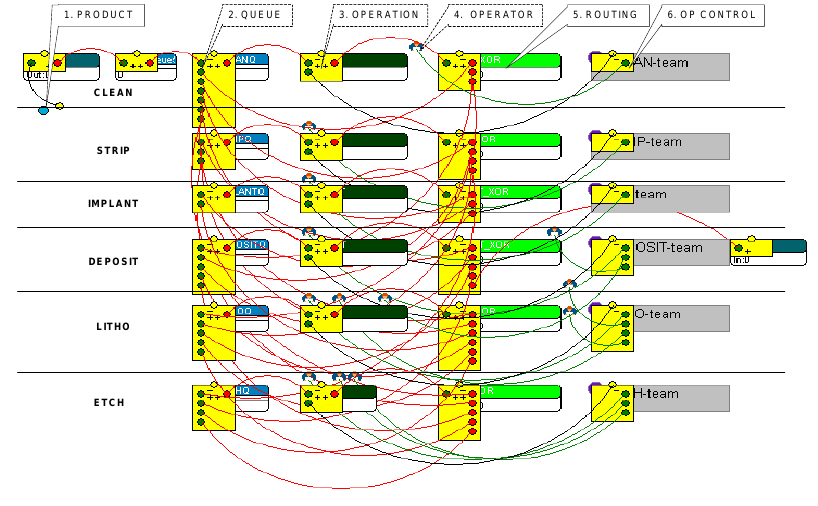
Figure 9. “A Snapshot of ED model from